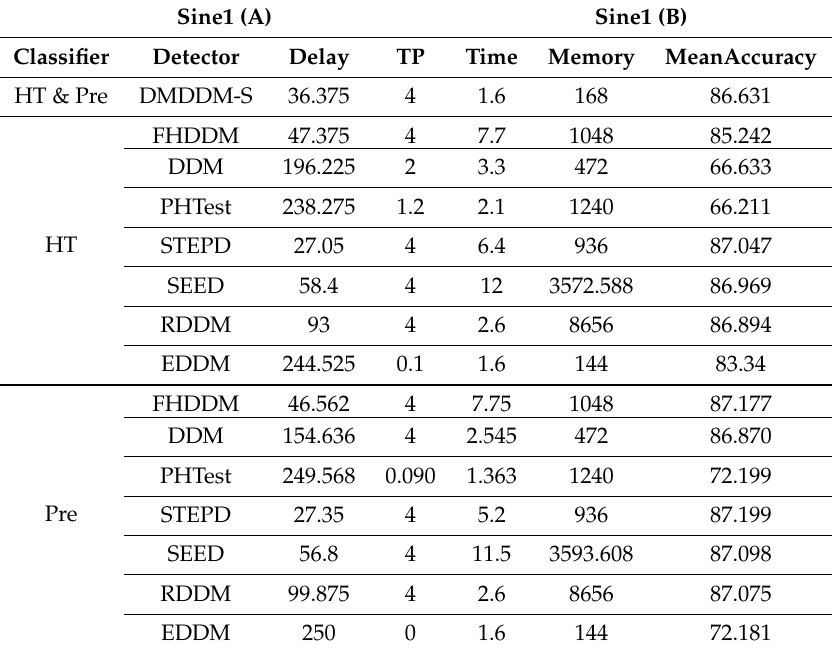
Table 2. Results of Sine1 dataset with (10%